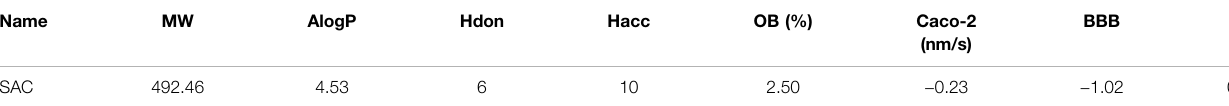
TABLE 1 | Pharmacological and molecular properties of SAC.